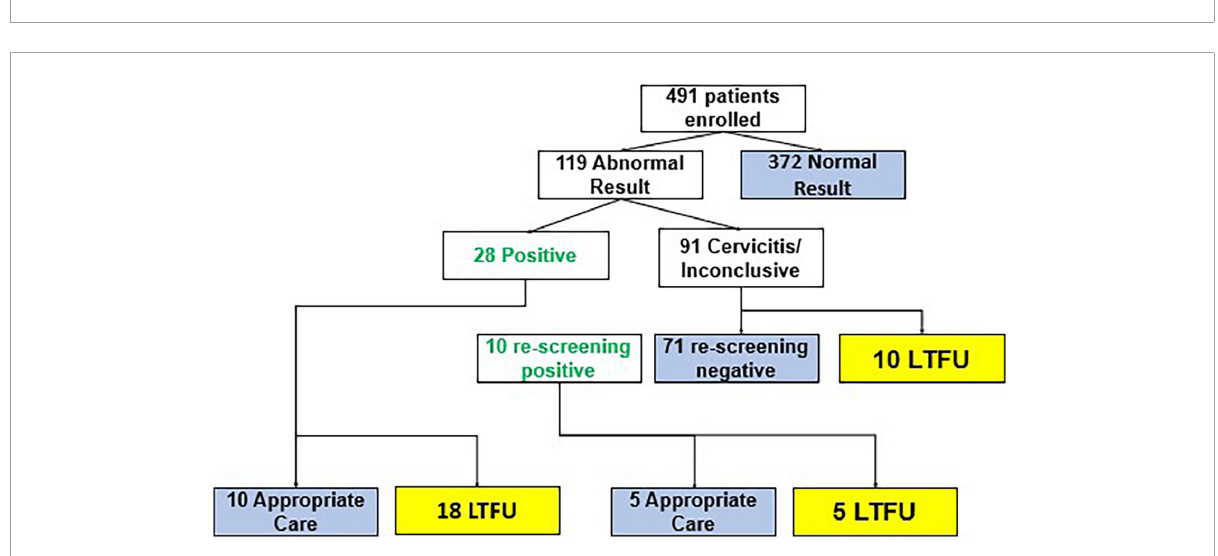
FIGURE2 Cancer tracking system (CATSystem) dashboard.